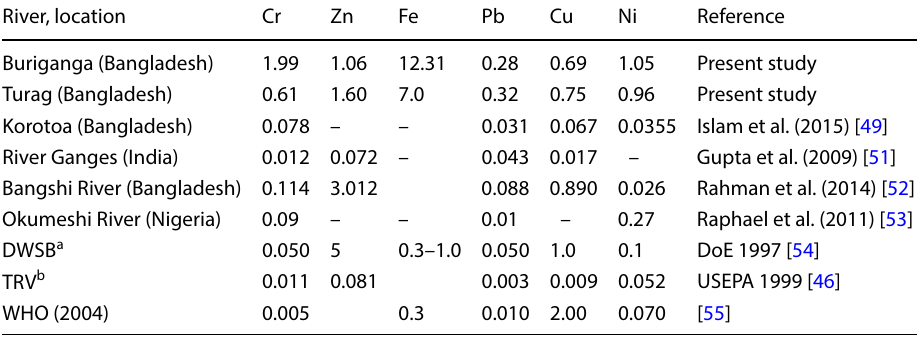
a Drinking water standard for Bangladesh proposed through ECR (Department of Environment,